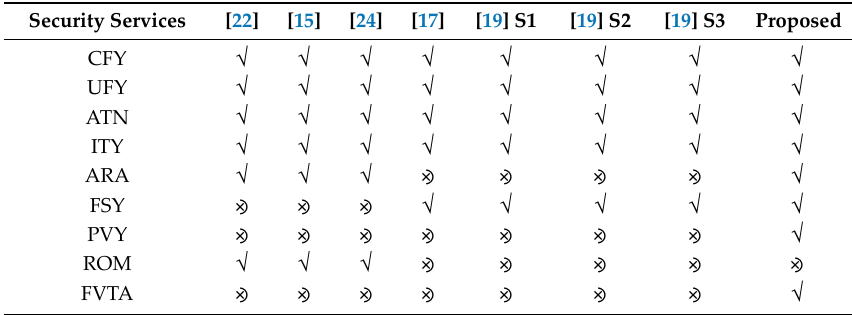
Table 2. Comparison with respect to security properties.